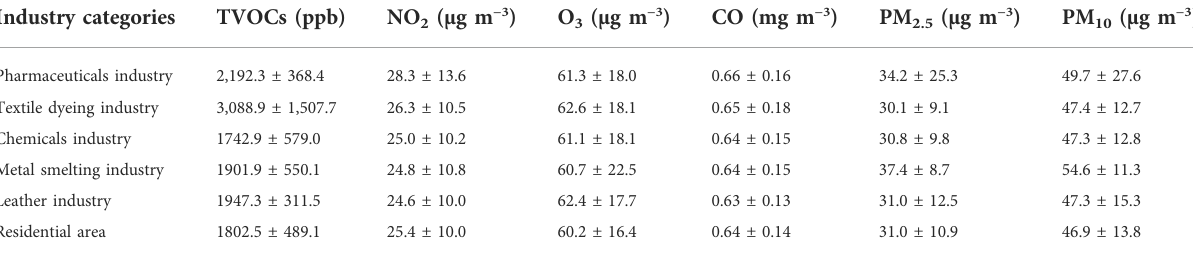
TABLE 1 The annual mean values of air pollutants in different industries were